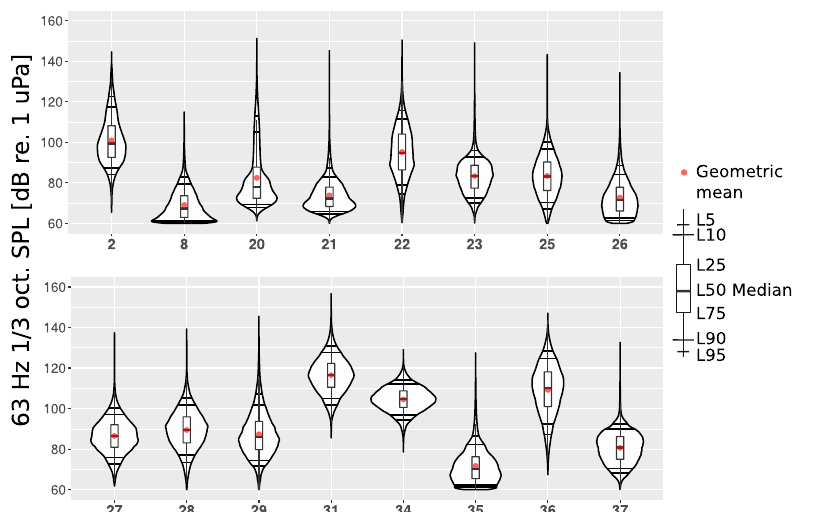
Figure 4. The estimated probability density functions of the measured SPL in sixteen different locations in the 63 Hz one-third octave band measured during the year 2014. The horizontal black lines represent L95, L90, L10, L5; the red dot marks the geometric mean (GM); the upper and the lower lines of the boxplot mark L25, L75; the thicker black line in the middle of the boxplot marks the median of the